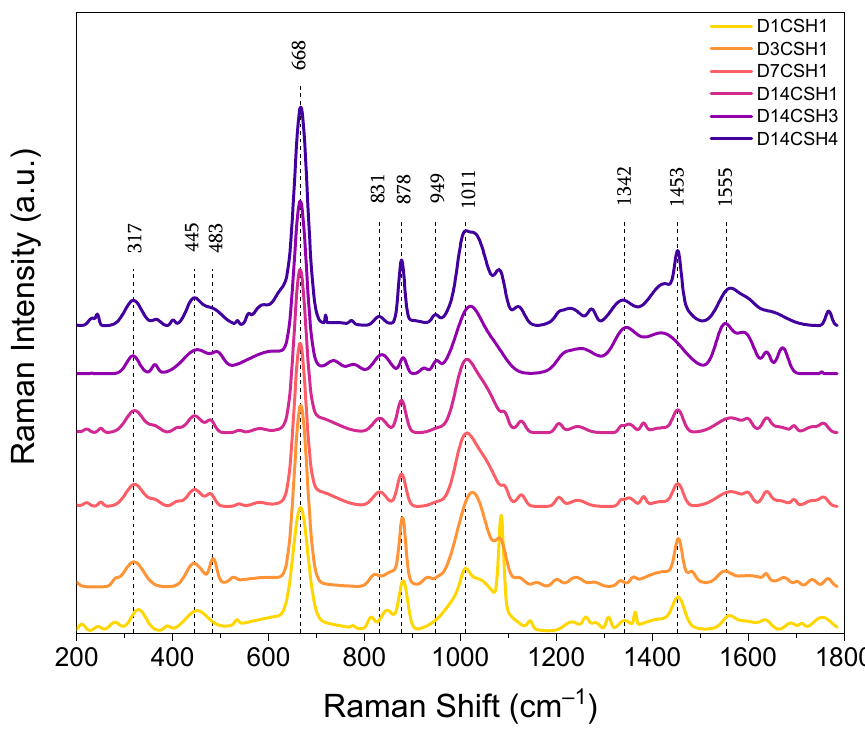
Figure 9. Raman spectra of the CSH gels at different ages. Two peaks at about 445 cm − 1 and 483 cm − 1 associated with υ 2-type internal deformations (O non –Si–O nonbending vibrations) and υ 4-type asymmetric bending (ASB) vibrations of SiO4 tetrahedra, respectively [60,63] were observed from both the plain and polymer-modified CSH gels. As can be seen, the prominent peak at 445 cm − 1 exhibited a decreased intensity in the CSH1 with time, while the intensity of this peak was increased in the presence of the PAAm-co-PAA (CSH3 and CSH4). In a study by Garbevet et al. [60], it was stated that the Si–O non –X structure can be influenced by the nearest neighbor atoms and that the change in the Ca/Si ratio can change the values of full width at half